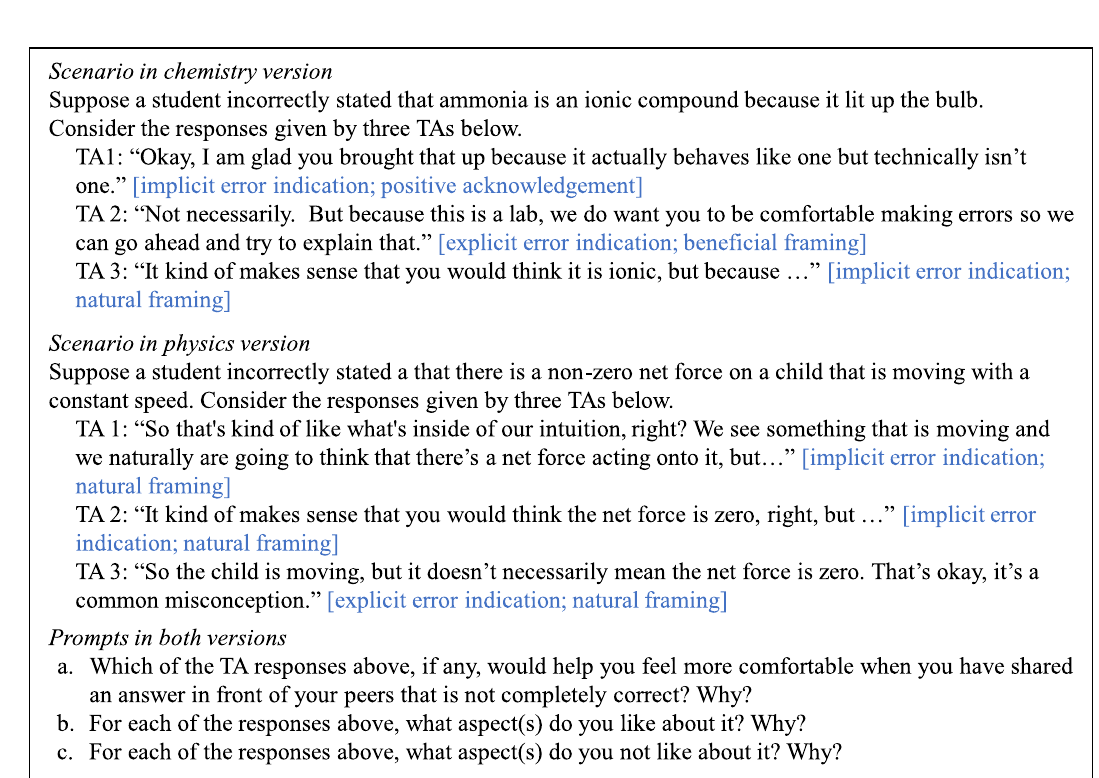
Table 3 Themes and codes of undergraduate students’ perception of GTAs’ error framing statements and impact on student comfort Theme